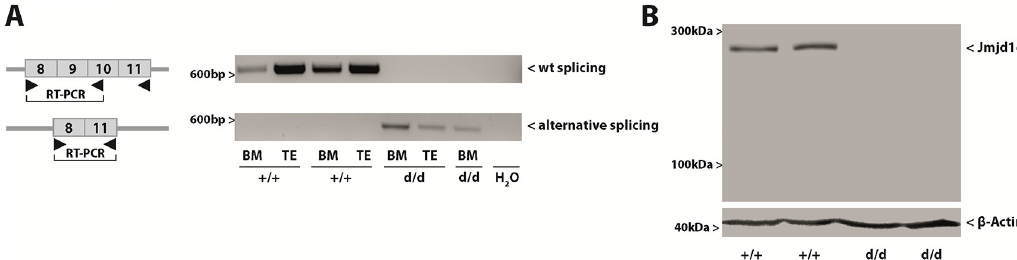
Fig 3. Creation and validation of Jmjd1c d/d mice. (A) RT-PCRs using material obtained from bone marrow (BM) and testicular tissue (TE). (B) Western blotting showing the expression of Jmdj1c in Jmjd1c +/+ and Jmjd1c d/d mice. Proteins were extracted from testicular